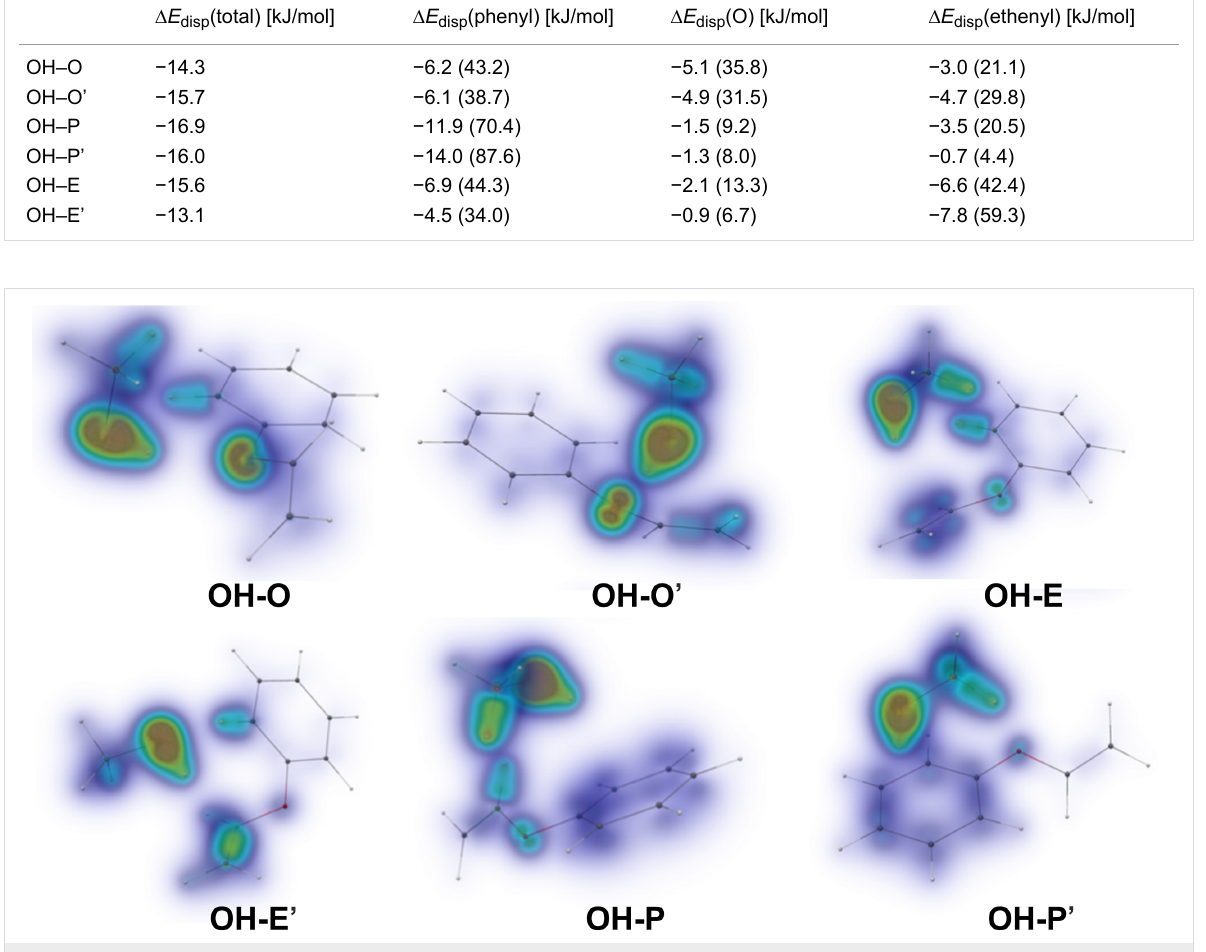
Figure 2: Dispersion interaction density (DID) plots calculated at the LCCSD/VQZ-F12 level. The brown zones indicate regions of electron density in a monomer which interact strongly by dispersion interactions with the other molecule. Blue stands for weaker/diffuse contributions. For example, in the top left figure one can observe that the OH group of methanol interacts strongly with the ether oxygen, with some dispersion energy coming as well from a CH orbital in the phenyl close to the